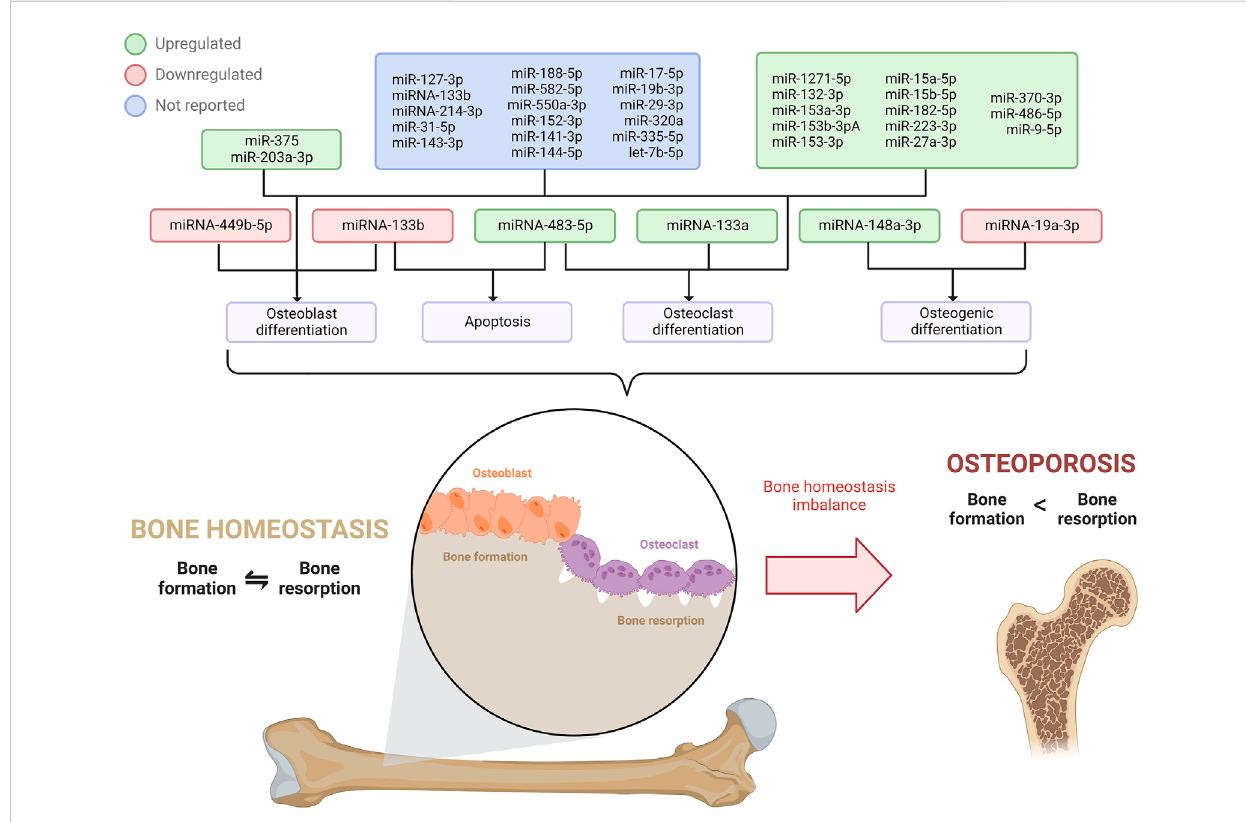
miRNAs expressions pro fi le involved in osteoblast, osteoclast, and osteogenic differentiation, and apoptosis that disrupts bone homeostasis, ultimately leading to